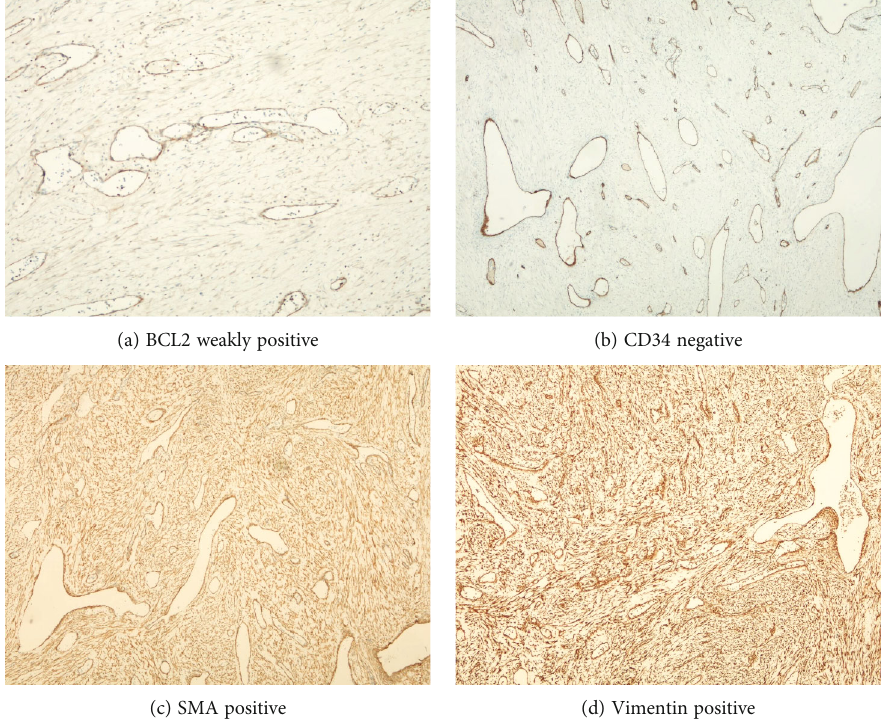
Figure 4: Immunohistochemical analysis using di ff erent